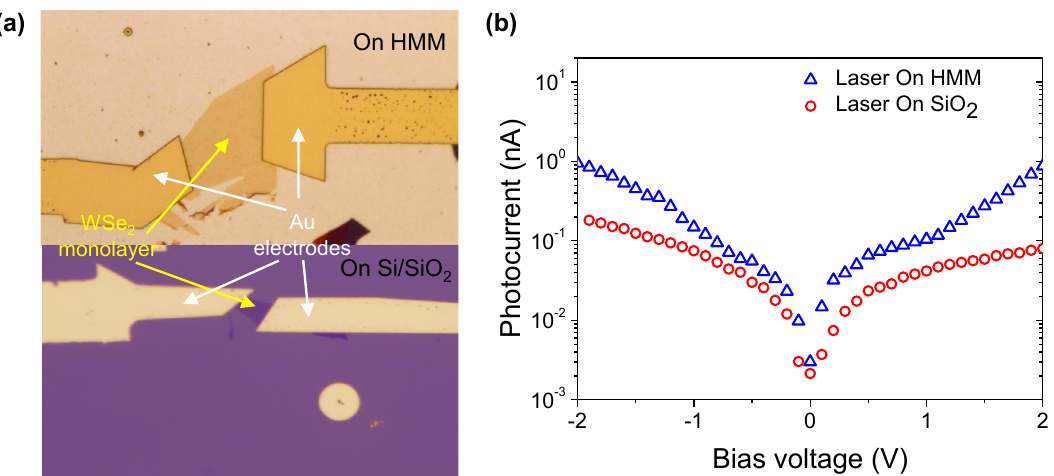
Figure 4: Enhancement of the photocurrent resulting from prolonged exciton lifetime. (a) Optical microscope images of WSe (bottom) and hyperbolic metamaterial (top). (b) Measured photocurrent of the devices in (a); WSe voltage varies while the 532 nm laser is